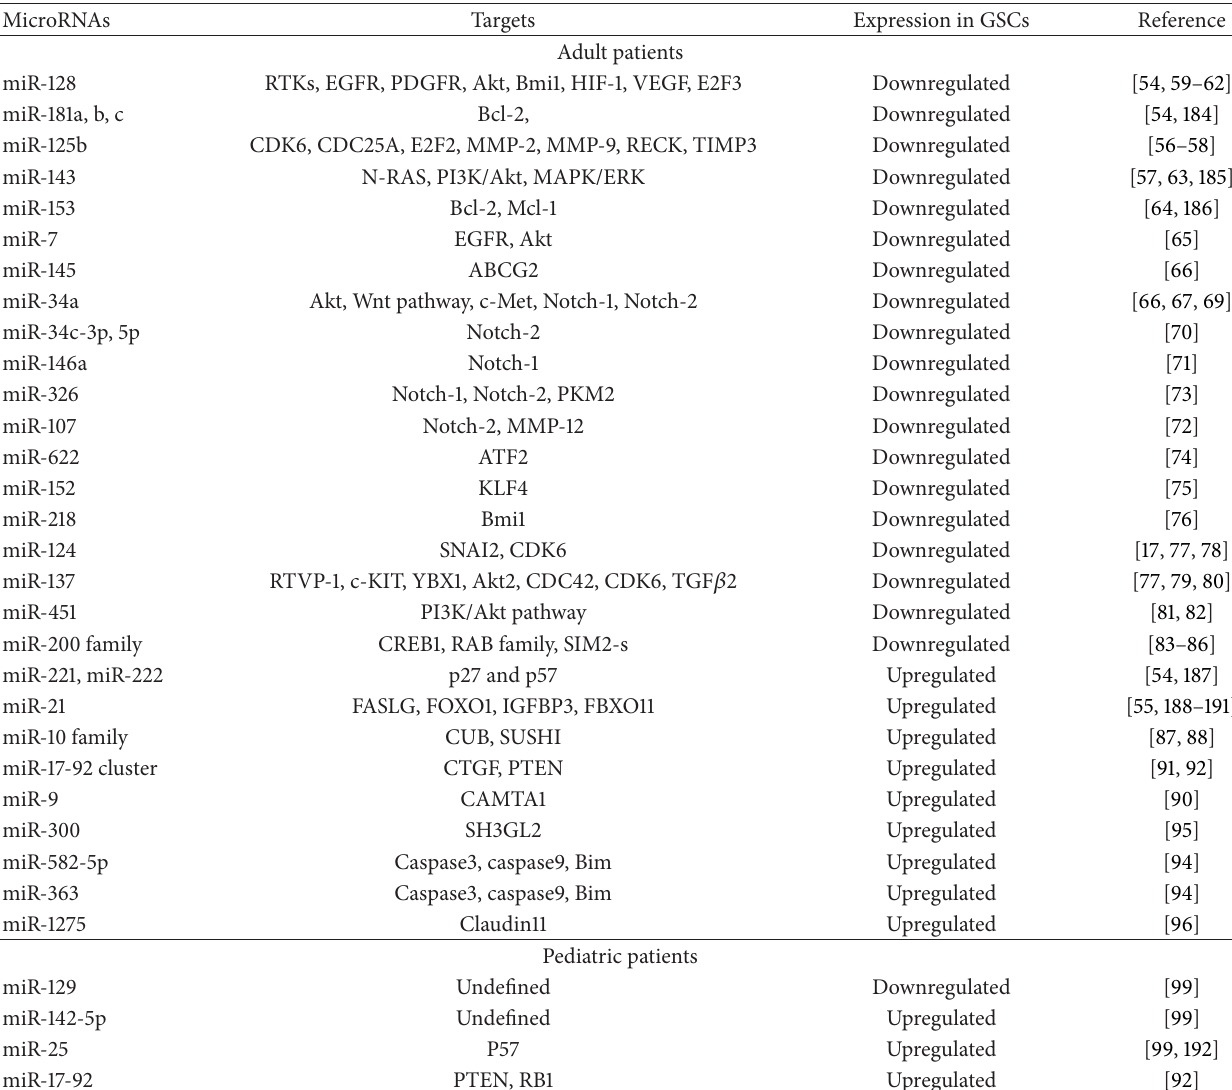
Table 1: miRNAs regulating BTICs in gliomas and GBM stem